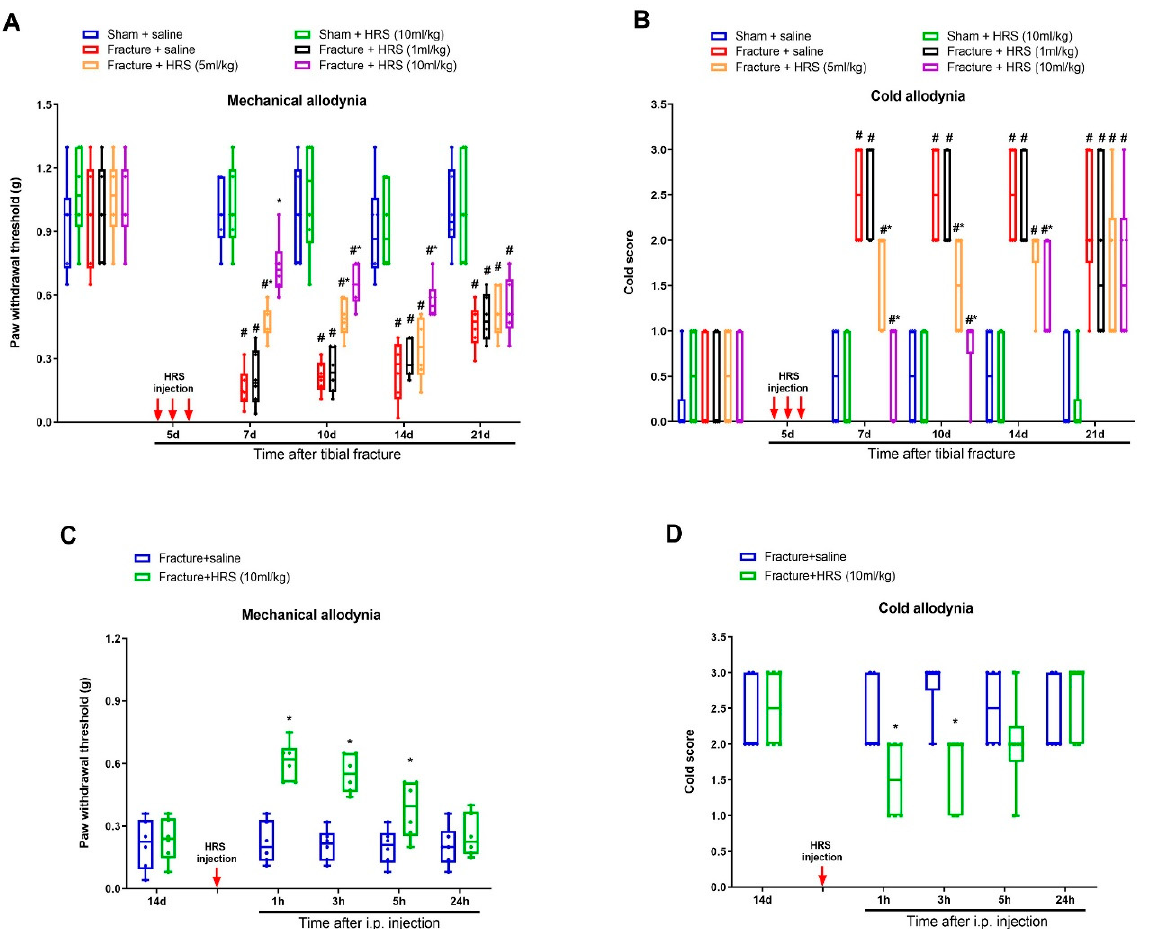
Figure 1. Systemic administration of hydrogen-rich saline reduces fracture-caused chronic allodynia. Intraperitoneal (i.p.) hydrogen-rich saline (HRS, 1, 5 and 10 mL/kg) was injected daily for 3 consecutive days on days 4, 5 and 6 (indicated by red arrows) after tibial fractures. The development of mechanical allodynia was assessed by paw withdrawal mechanical threshold ( A ) in von Frey test after fracture and HRS injections. The development of cold allodynia was assessed by cold response scoring ( B ) in acetone test after fracture and HRS injections. ( C , D ) A single HRS injection (i.p., 10 mL/kg) on day 14 after orthopedic surgeries reduces the established mechanical allodynia and cold allodynia. Results are expressed as medians with interquartile ranges and individual data plots ( n = 6). All behavioral data are analyzed by two-way ANOVA with Bonferroni post hoc comparisons. # p < 0.05 vs. group Sham + saline, * p < 0.05 vs. group Fracture + saline.